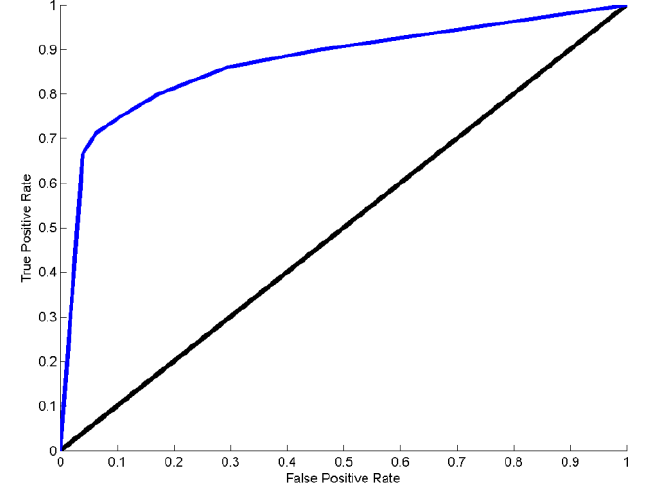
Figure 20. ROC curve created from k-NN classifications with different